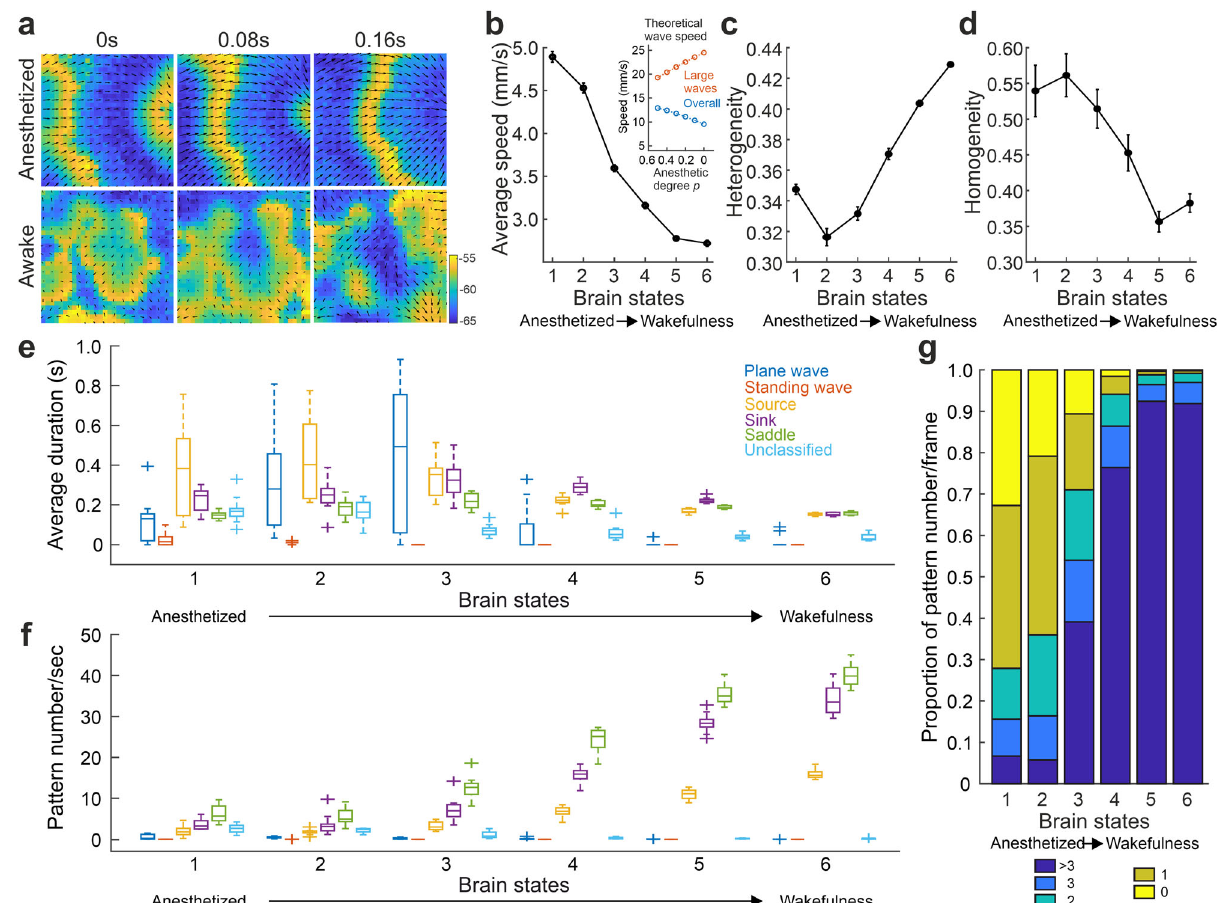
Fig. 6 | State-induced changes of wave patterns in neural mass model. a Examples of simulated wave patterns. Color indicates the value of voxel voltage. Upper: anesthetized state (model parameter p =0 : 5). Lower: awake state (model parameter p =0). b - g ,Spatiotemporalpropertiesduringwakingup.Brainstates1-6 correspond to parameter p =0 : 5,0 : 4,0 : 3,0 : 2,0 : 1,0 inourmodelsimulation, from anesthetized (state 1) to wakefulness (state 6). Error bar = SEM; N =10 trials. b The averagespeedofwaves.Inset:analyticalprediction(seeSI)oftheoverallandlarge- scalewavespeedsfromanesthetizedtowakefulnessstates.Notetheincreaseinthe speed of large waves (inset) but decrease in the overall wave speed with the